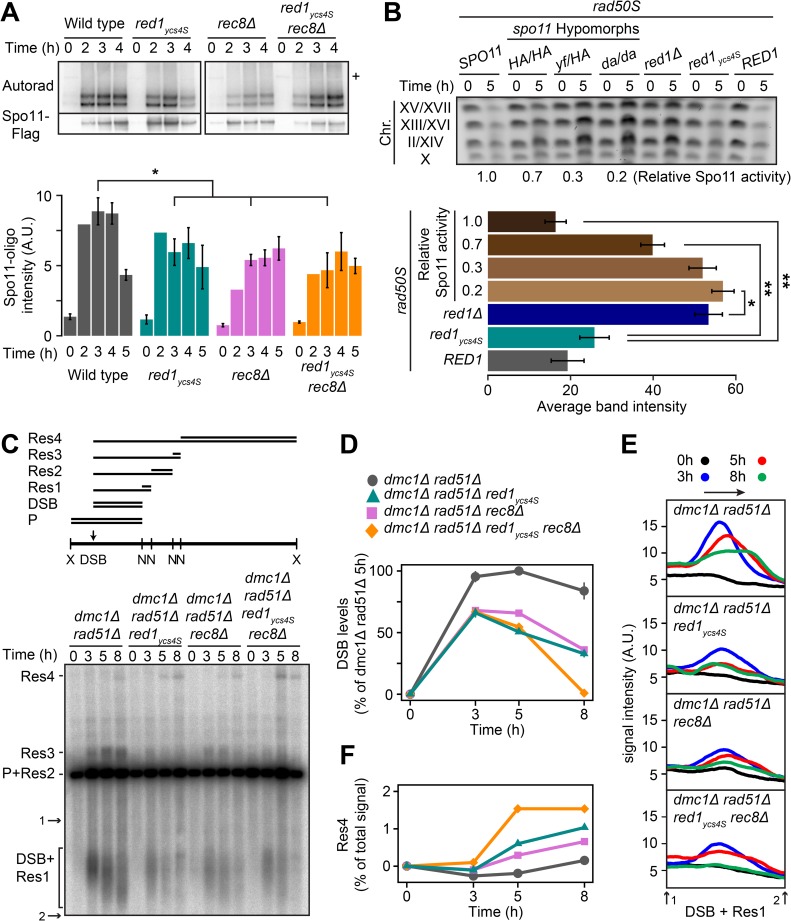
Lack of checkpoint arrest in red1ycs4S is not caused by insufficient DSBs or a lack of sustained resection.(A) Measurement of Spo11-oligonucleotide complexes as a measure of DSB level independent of resection or repair. Experiments were completed in wild-type (H9082), red1ycs4S (H9084), rec8Δ (H9083), and red1ycs4S
rec8Δ (H9085) strains. Upper panel: Representative autoradiograph of Spo11-oligo complex and measure of total Spo11 protein by anti-Flag western. Plus sign indicates non-specific band. Lower panel: Quantification of Spo11-oligo complex bands (background normalized), n = 4 for 0, 3, and 4h, n = 3 for 5h. Error bars: S.E.M. *: p-value < 0.05, paired Student t-test. (B) Upper panel: Ethidium bromide staining showing the levels of seven intact chromosomes in a red1Δ (H8058), red1ycs4S (H8096), and control (H8099) in a rad50S background compared to strains with defined DSB levels: 100% (H9202), 70% (H9203), 30% (H9204), and 20% (H9205) [65,66], see S1 Table. Lower panel: Levels of chromosome breakage quantified from top three bands above, n = 2. Error bars: S.E.M. *: p-value < 0.05, **: p-value < 0.005, paired Student t-test. (C) Upper panel: Schematic of the CCT6 hotspot indicating uncut parental band (P), DSB fragment length (DSB), and resection products (Res1-4) when genomic DNA is cut with XhoI (X) and NsiI (N). Lower panel: DSB and resection products at the CCT6 hotspot formed after meiotic synchronization in red1ycs4S (H7088), rec8Δ (H7161), and red1ycs4S
rec8Δ (H6589) mutants and their control (H7076) in a dmc1Δ rad51Δ background. Arrows 1 and 2 were used as anchors to measure signal accumulation in (E). (D) DSB levels as a percent of dmc1Δ rad51Δ at the CCT6 hotspot, n = 2 for dmc1Δ rad51Δ and dmc1Δ rad51Δ red1ycs4S. Error bars: range. (E) Linescans of DSB band from gel in (C). Arrow indicates accumulation of faster migrating bands over time in dmc1Δ rad51Δ. (F) Rate of accumulation of signal at Res4 as a percent of lane total. Values have been normalized against signal of all bands in the lane and followed by subtraction of the value at 0h.